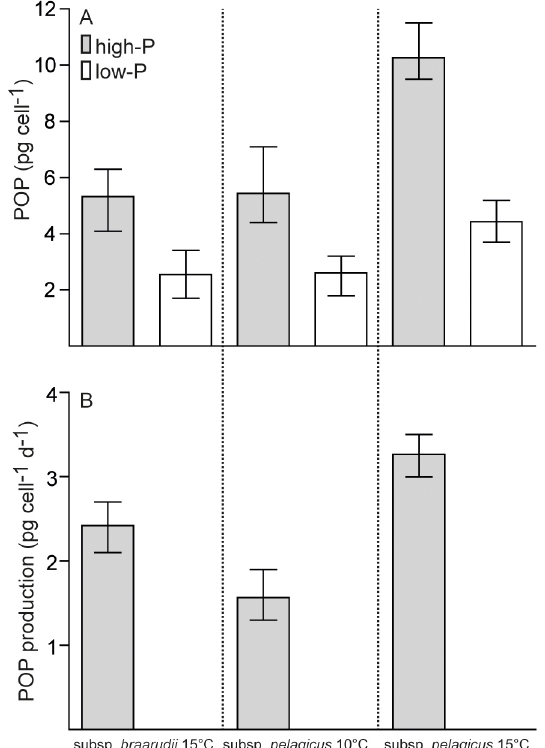
Figure 1. (A) Particulate organic phosphorus (POP) quotas of Coc- colithus pelagicus subsp. braarudii grown at 15 ◦ C and subsp. pelagicus grown at 10 and 15 ◦ C, in high-P and low-P medium. (B) POP production in high-P cultures. Mean ± min/max; values for subsp. braarudii at 15 ◦ C and subsp. pelagicus at 10 ◦ C are av- erages of the main and additional experiments ( n = 6); for subsp. pelagicus at 10 ◦ C, n =